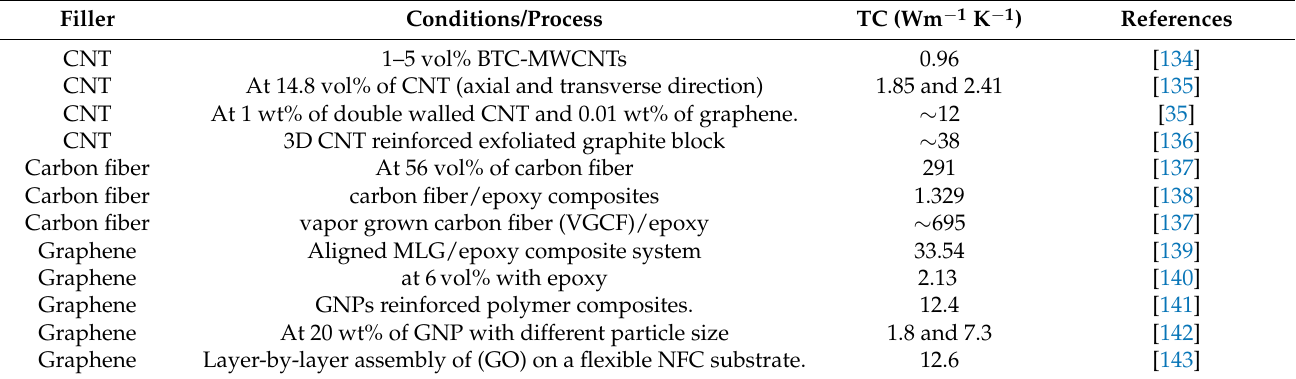
Table 3. Summary of the recently published works on carbon-based fillers.